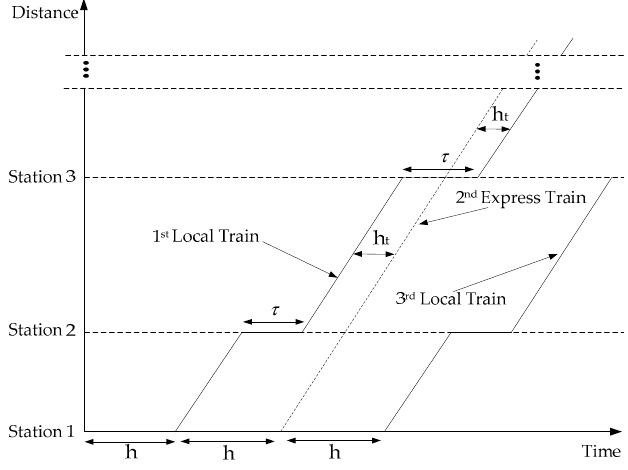
Figure 2. Minimum headway t h depicted as a time-space diagram.